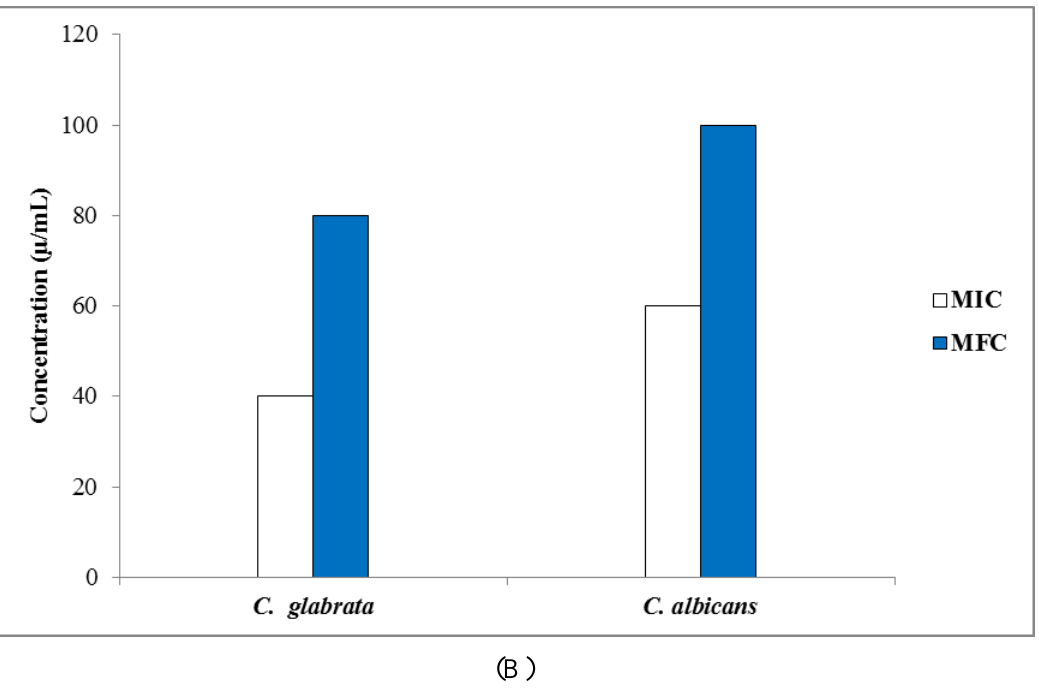
Figure 7. ( A ) Values of minimum inhibitory concentration (MIC) and minimum bactericidal concentration (MBC). ( B ) Values of minimum inhibitory concentration (MIC) and minimum fungicidal concentration (MFC) of biosynthesized AgCl-NPs against tested strains.